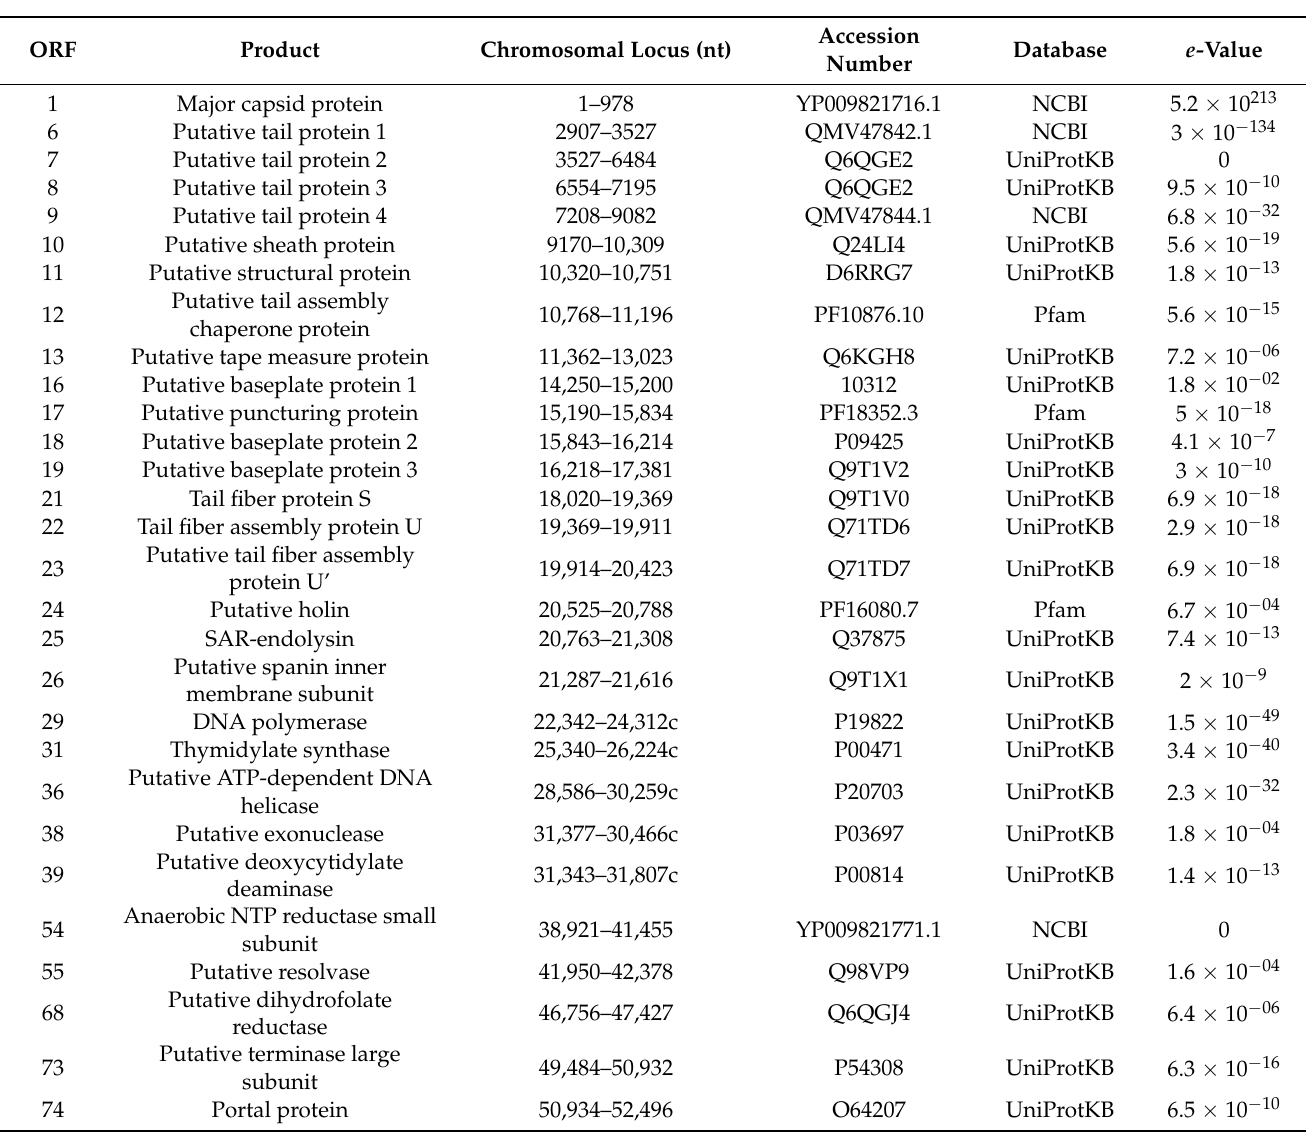
Table 2. Bacteriophage S1 ORFs with known and putative